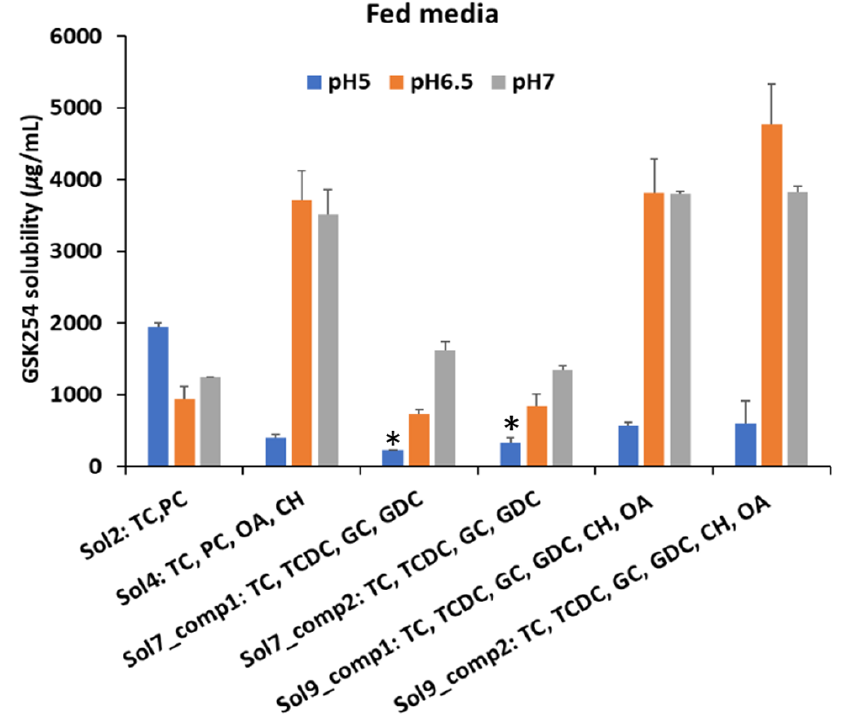
Figure 4. Bar chart (mean, ± SD) of GSK254 equilibrium solubility (24 h) values in different compositions of fed media at 5, 6.5 and 7 pH; sodium taurochenodeoxycholate (TCDC); sodium taurocholate hydrate (TC); sodium glycodeoxycholate (GDC); sodium glycocholate hydrate (GC); cholesterol (CH); oleic acid (OA); L-alpha- phosphatidylcholine from egg yolk (PC). Refer to Table 2 for the exact recipe of composition 1 (comp1) and composition 2 (comp2). * Sol7_comp1&2@pH5 do not contain PC; solubility measurements were conducted in each composition in triplicates (n = 3).